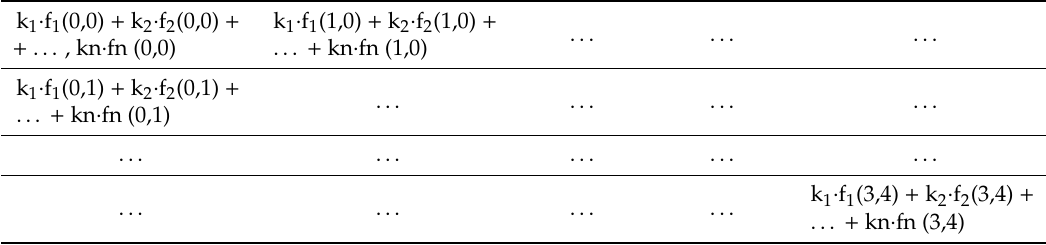
Table 3. Algorithm in a tabular